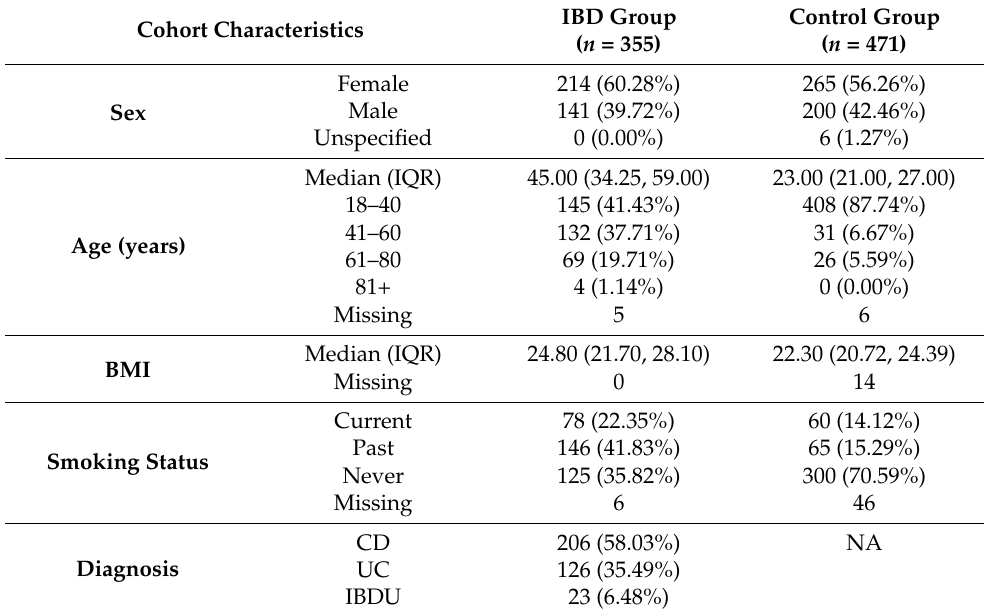
Table 1. Summary characteristics of the study groups included in regression